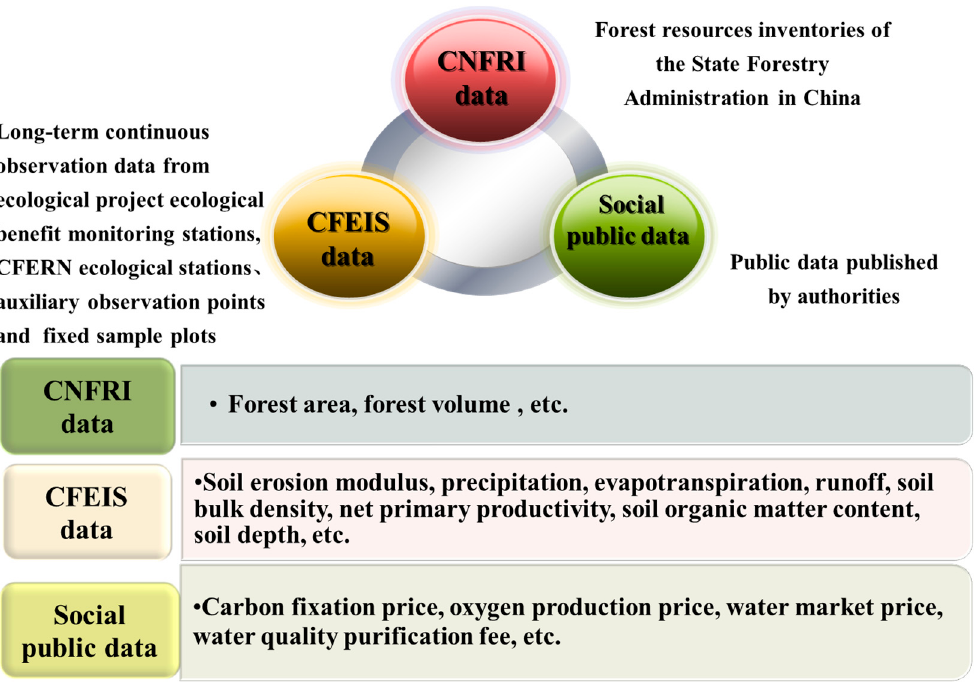
Figure 6. Data sources and integration in CFEIS.